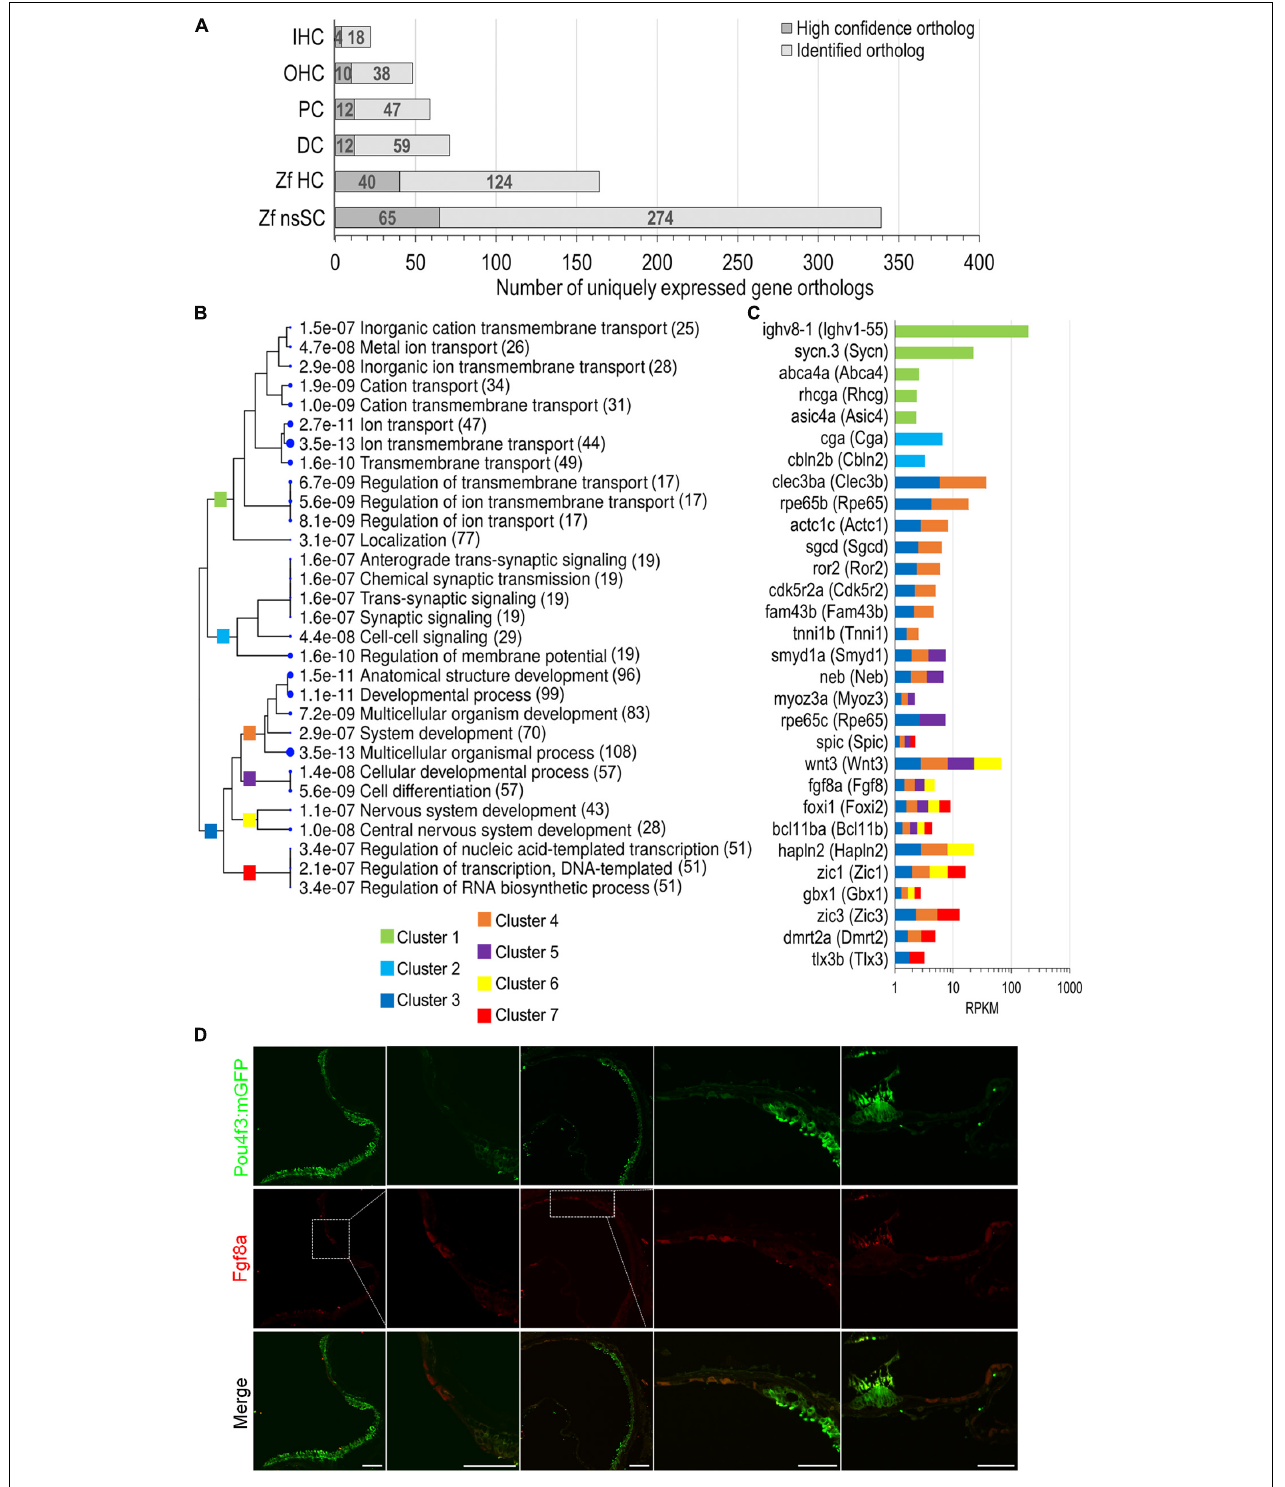
FIGURE 6 | Unique expression of gene orthologs in nsSCs. (A) Total number of uniquely expressed protein-coding gene orthologs in zebrafish and mouse inner ear cells. The dark gray portion of the bar indicates the proportion of high-confidence orthologs, out of the total unique orthologs, that were uniquely expressed in each cell type ( ≥ 0.10 RPKM) while below cutoff expression in the five other cell types. (B) The most significantly enriched biological process categories identified in a ShinyGO analysis of 339 uniquely expressed nsSC ortholog genes. The clustering tree indicates relatedness among the biological processes. There are no